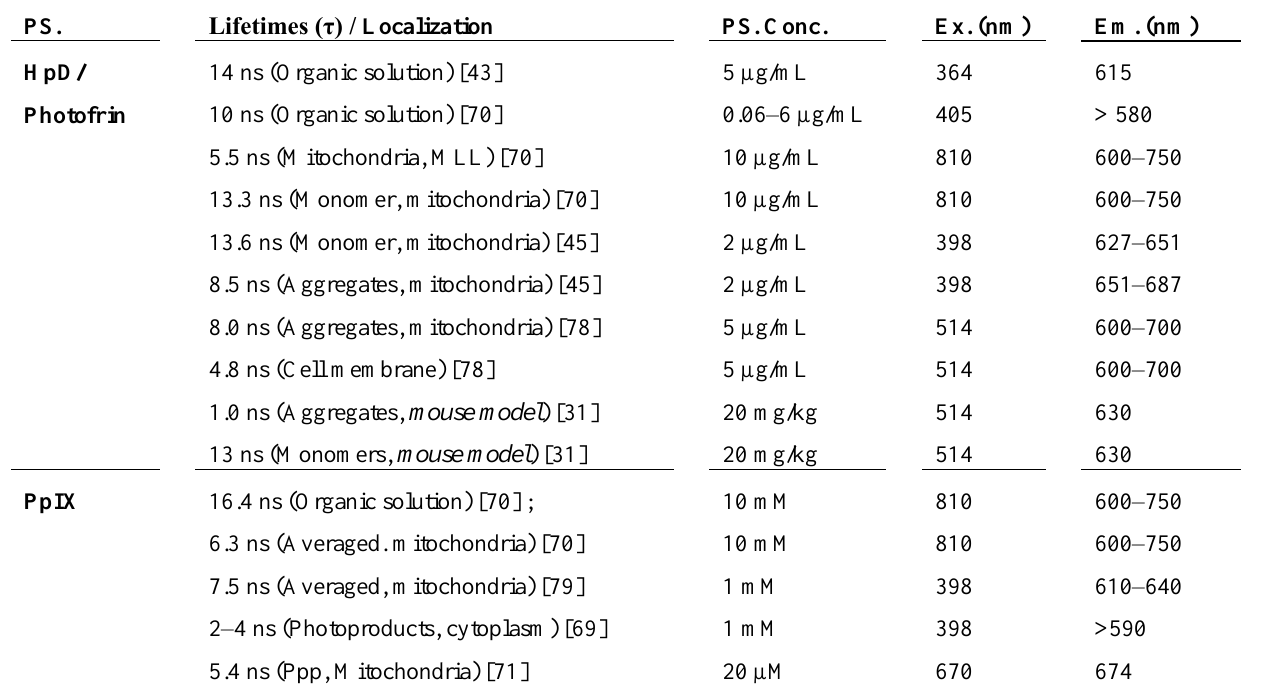
Table 4. Summary of TRF studies of